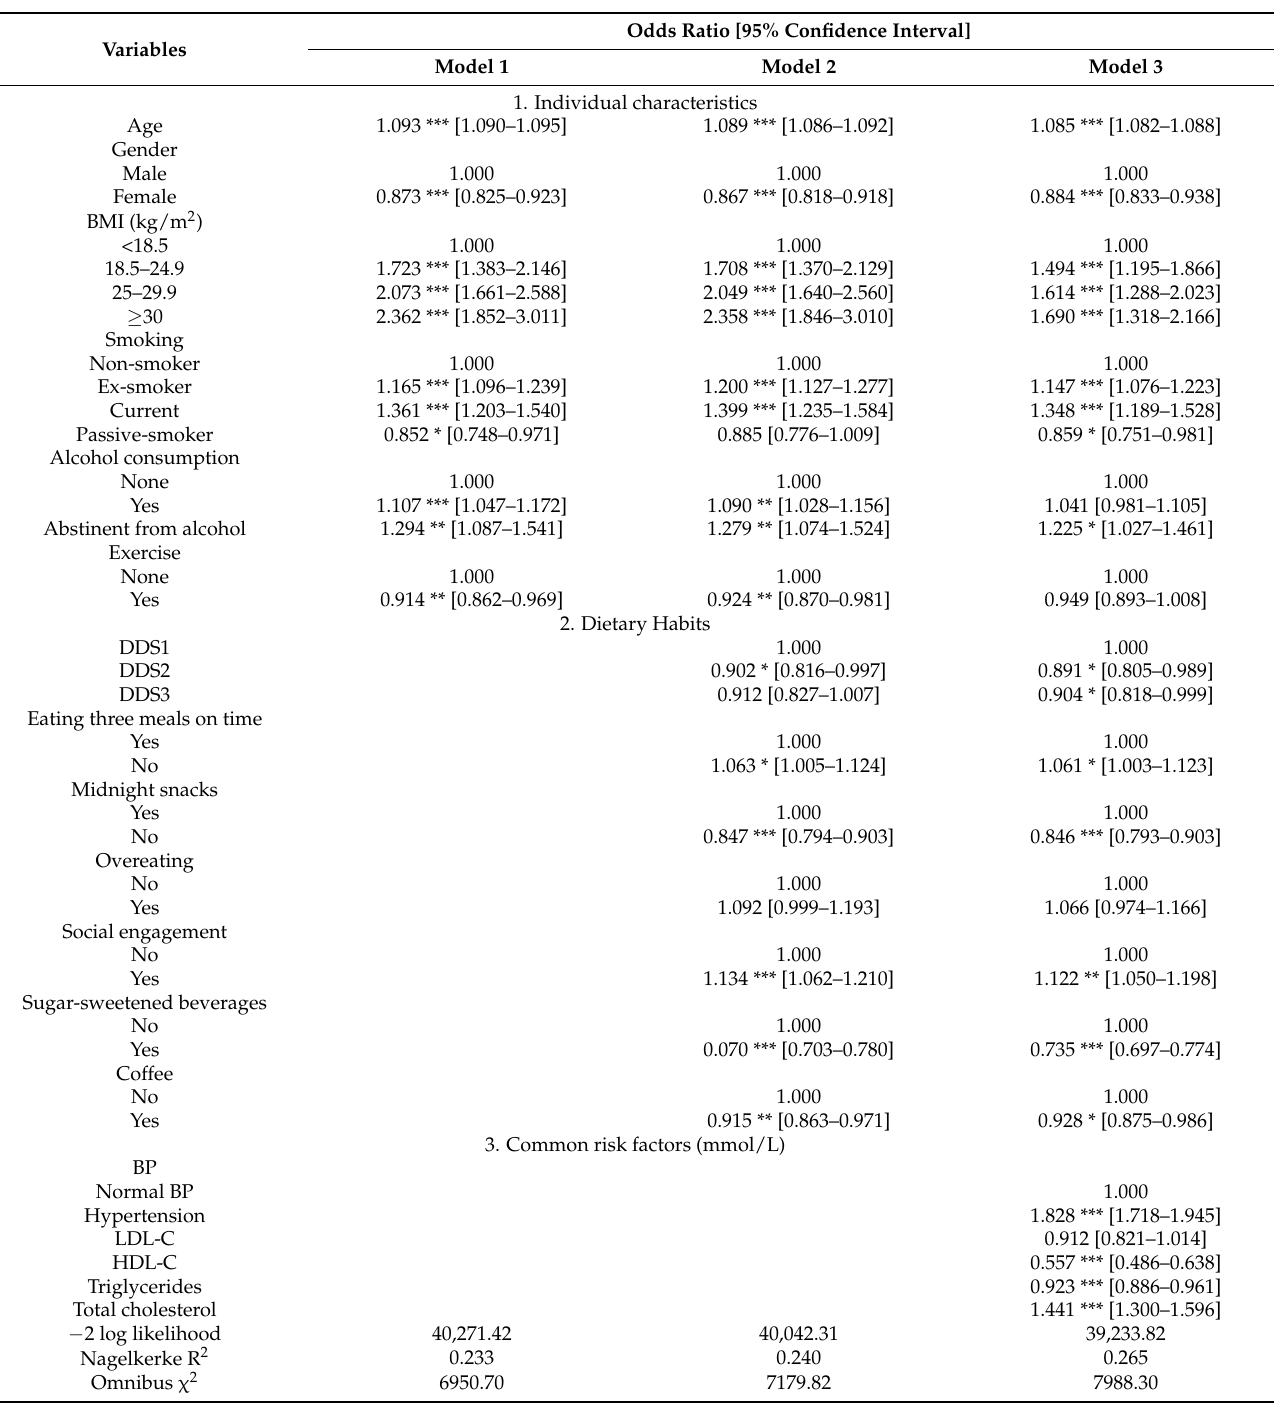
Table 2. Multilevel logistic regression analysis of the relationship between carotid atherosclerosis and individual characteristics, diet habits, and common risk factors ( N =